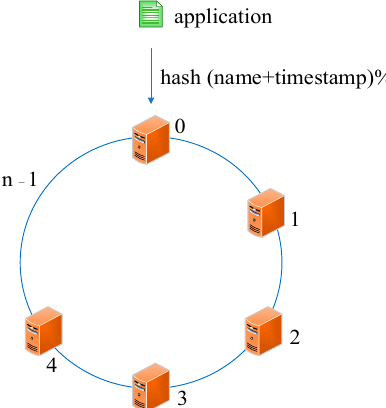
Figure 4. A sequence-based deploying approach.